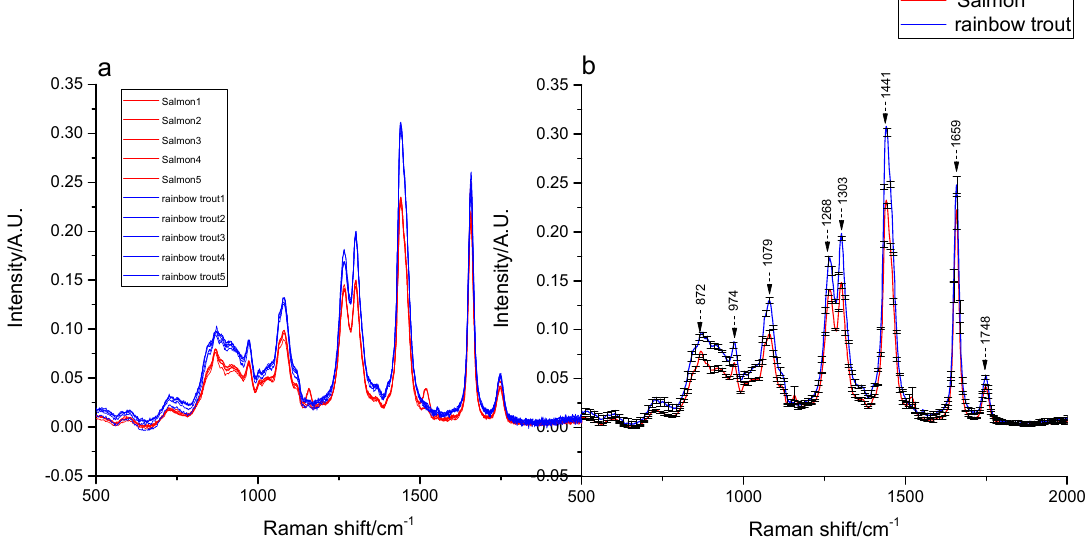
Figure 1. The Raman spectra of fat in Atlantic salmon and rainbow trout. ( a ) The five spectra of salmon and rainbow trout after baseline correction and multiple scattering correction (MSC). ( b ) The mean and standard deviation spectra of salmon and rainbow trout.